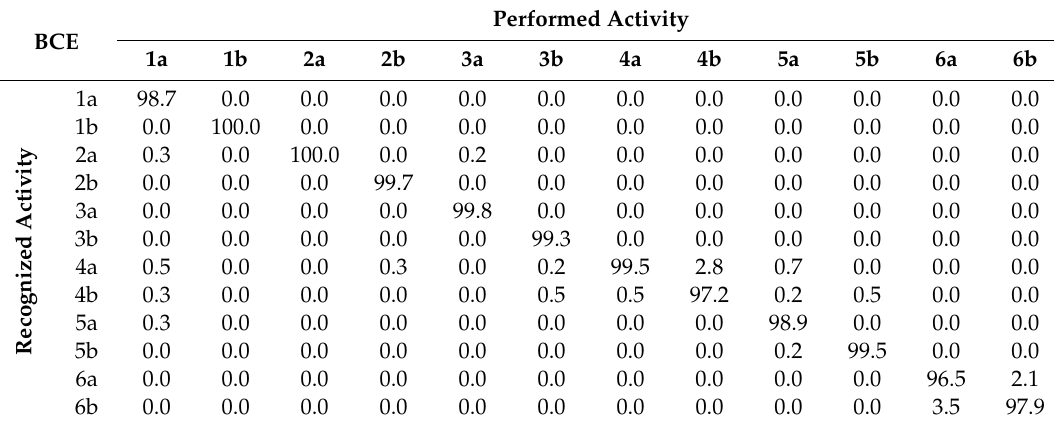
Table A8. Matrix of recognition errors (in %) of 12 motor activities 1a ÷ 6b in test set for all volunteers together for sensor BCE.